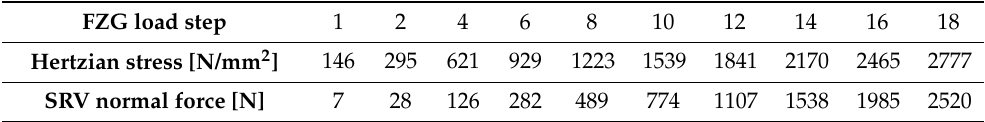
Table 2. SRV EP Procedure vs FZG test load